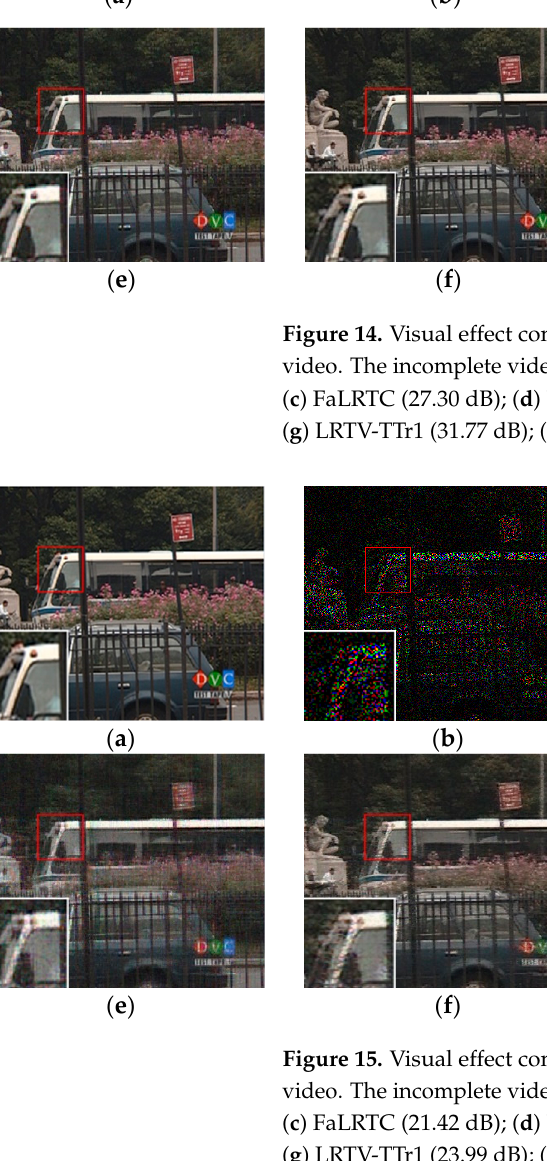
Figure 15. Visual effect comparison of different methods on the ninth frame completion of the Bus video. The incomplete video contains 80% missing entries. ( a ) Original image; ( b ) Incomplete image;